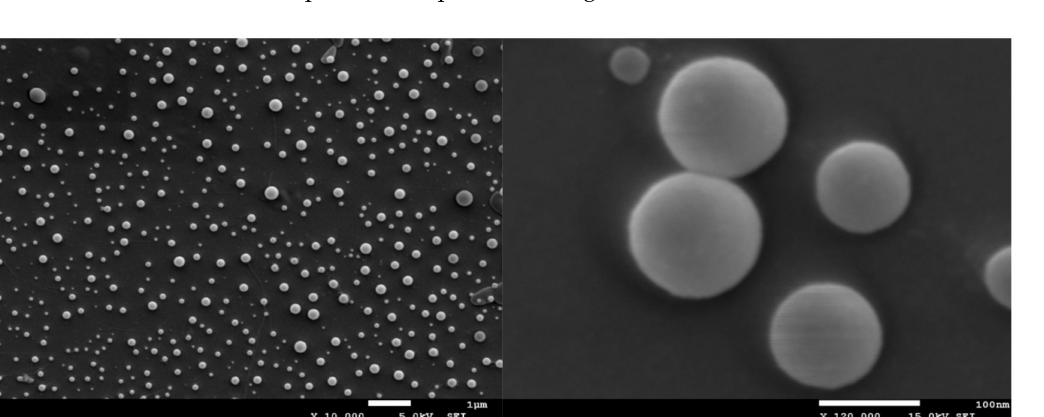
Figure 1. pNiPAM-HEMA-AA-oligoLA spherical nanoparticles’ evaluation in scanning electron